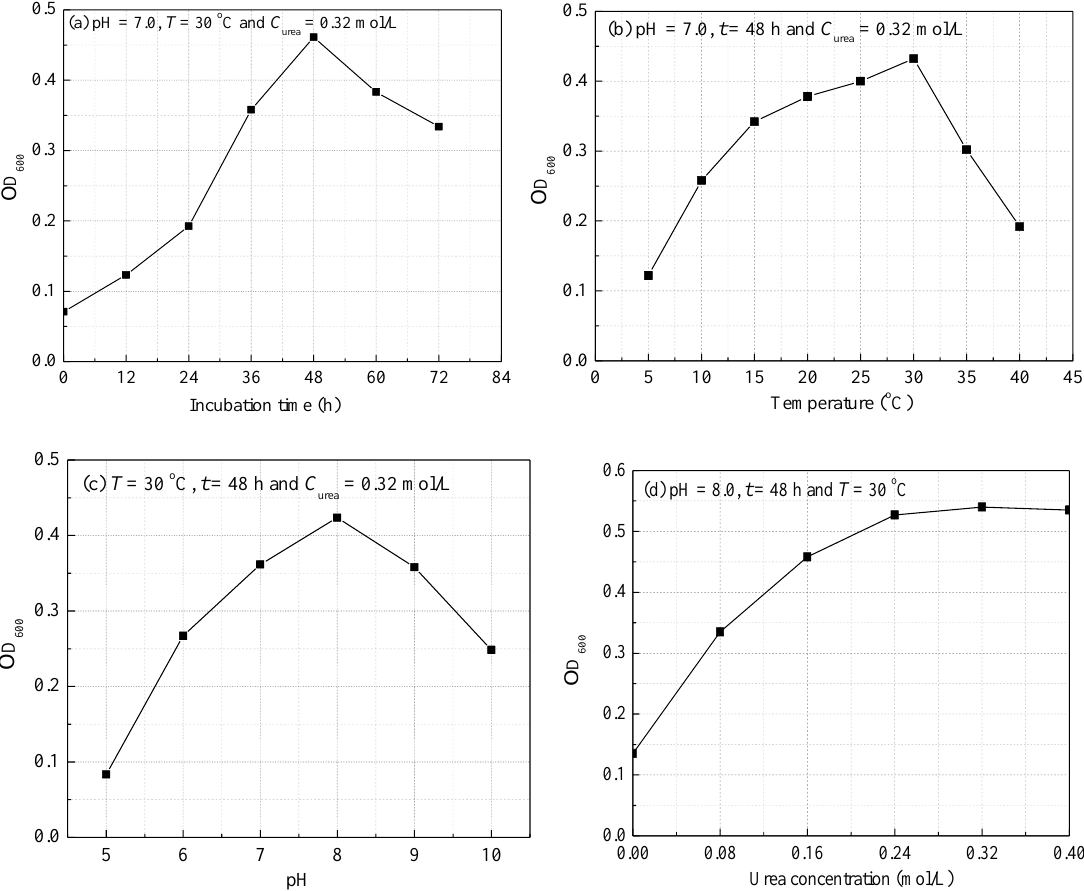
Figure 3. Growth characteristics of S. pasteurii under different conditions (( a ) pH = 7.0, T = 30 o C and C urea = 0.32 mol/L; ( b ) pH = 7.0, t = 48 h and C urea = 0.32 mol/L; ( c ) T = 30 o C, t = 48 h and C urea = 0.32 mol/L; ( d ) pH = 8.0, t = 48 h and T = 30 o C).